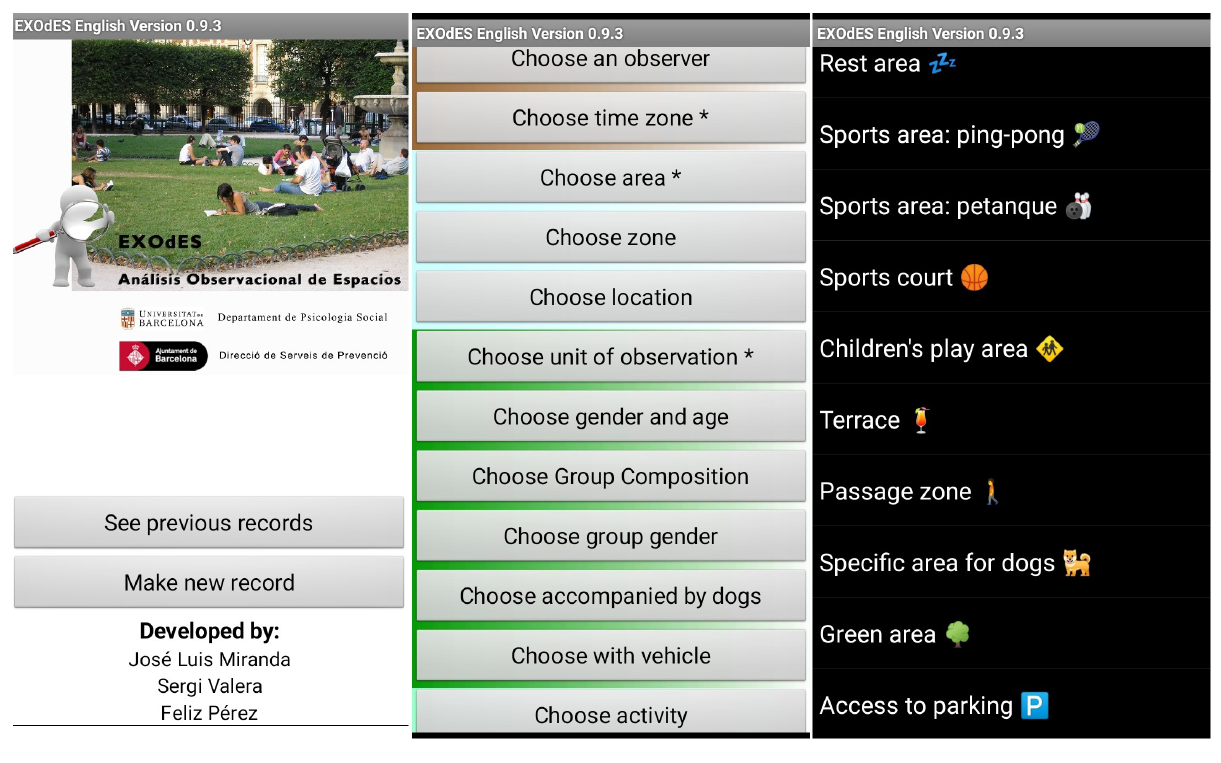
along different time slots (36 sessions per case study) representing 27 h per site, which is 81 h in total (see Table 1